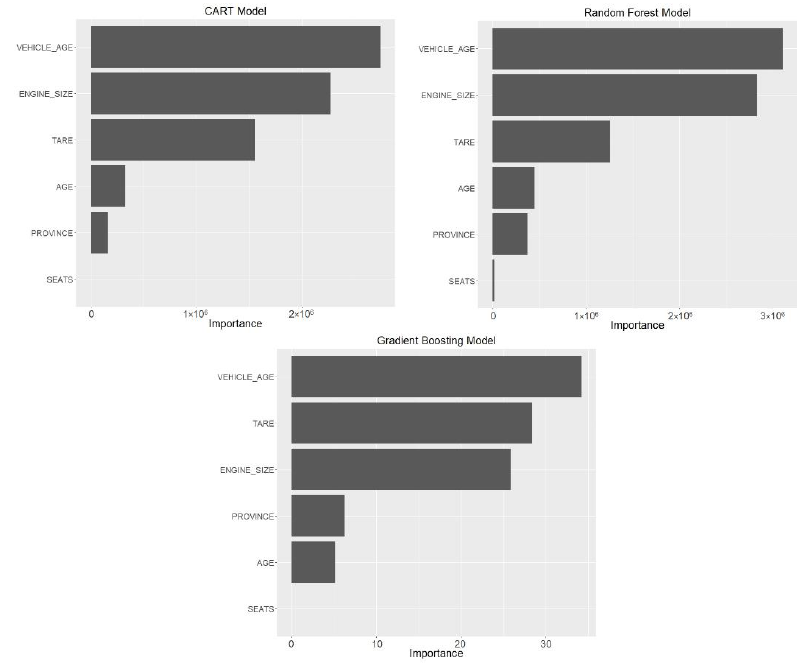
Figure 7. Importance of the